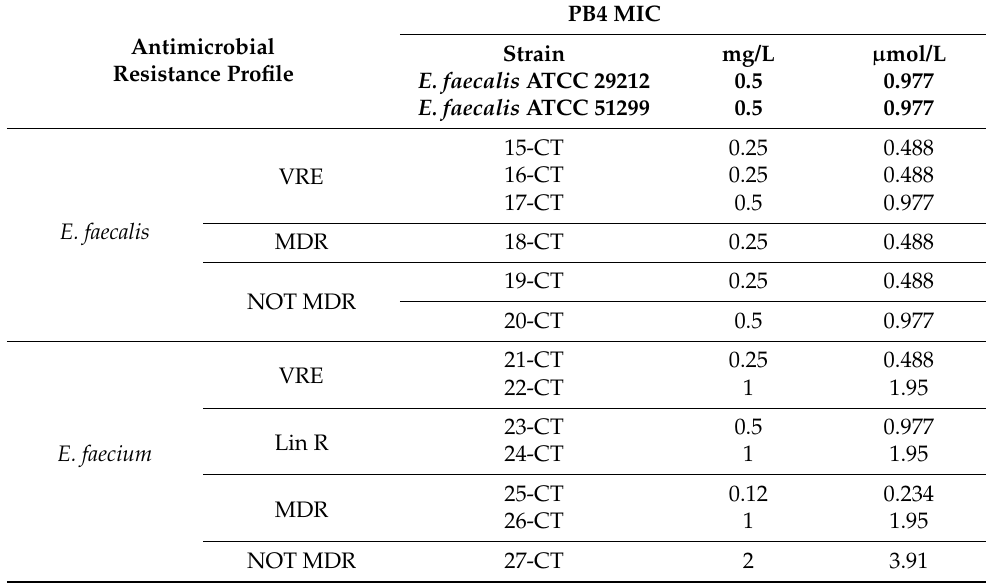
Table 2. Activity of PB4 on E. faecalis ATCC 29212 and E. faecalis ATCC 51299 control strains, on six E. faecalis and on seven E. faecium clinical strains (VRE, LinR, MDR, not